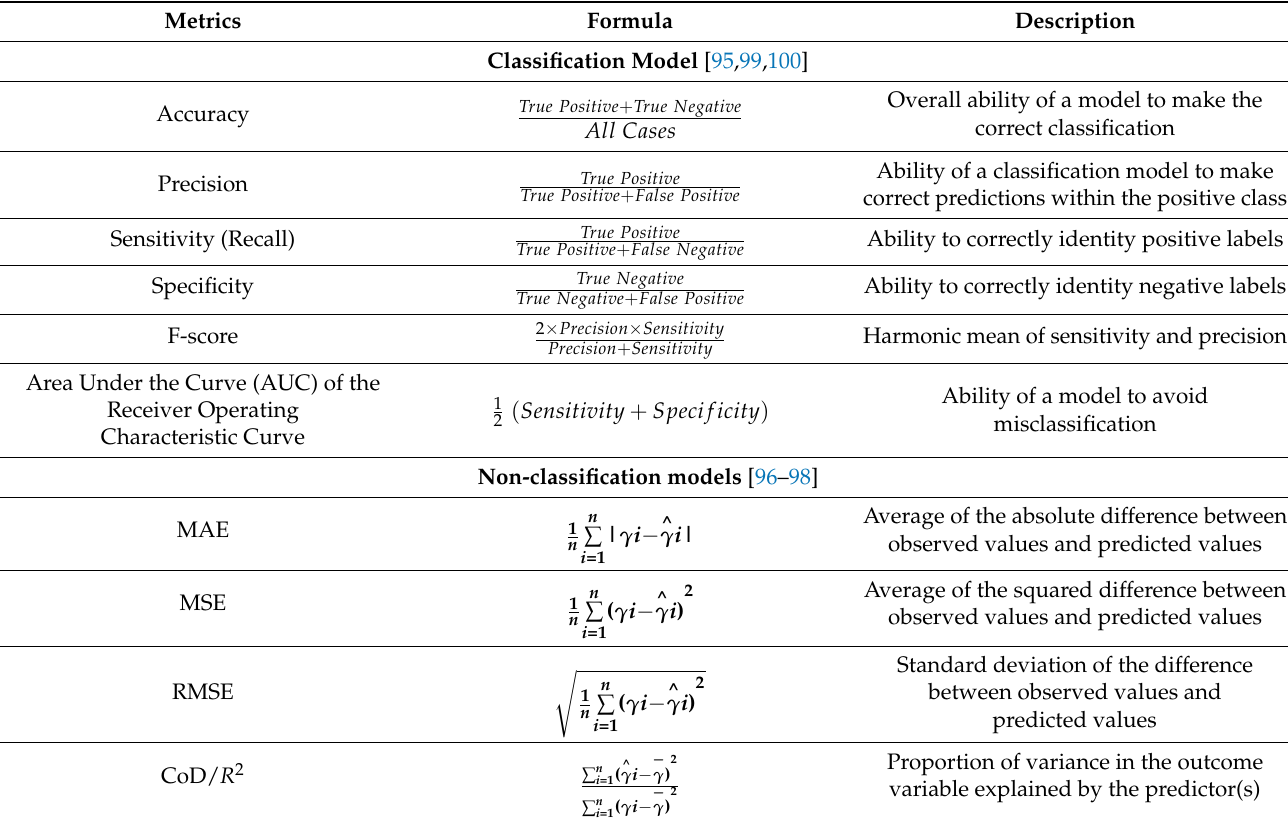
Table 3. Key Performance Metrics of Machine Learning Models.